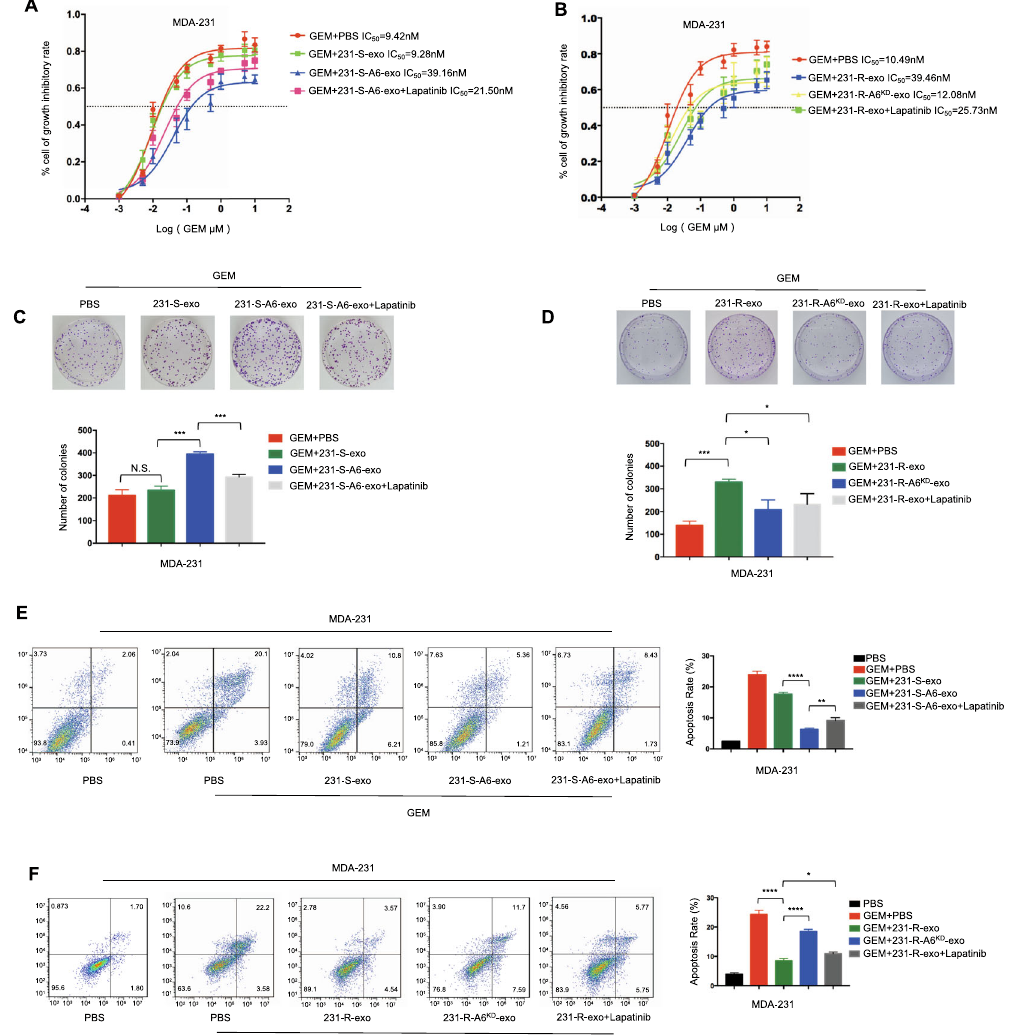
Fig. 6 EGFR-TKI reverses gemcitabine (GEM) resistance induced by exosomal ANXA6. A , B IC 50 values determined using the CCK-8 assay in MDA-231 cells treated with GEM + PBS, GEM + 231-S-exo, GEM + 231-S-A6-exo, and GEM + 231-S-A6-exo + lapatinib for 48 h or GEM + PBS, GEM + 231-R-exo, GEM + 231-R-A6 KD -exo, and GEM + 231-R-exo + lapatinib for 48 h. C , D Colony formation in MDA-231 cells treated with GEM + PBS, GEM + 231-S-exo, GEM + 231-S-A6-exo, or GEM + 231-S-A6-exo + lapatinib for 24 h and incubated for 7 days or GEM + PBS, GEM + 231-R-exo, GEM + 231-R-A6 KD -exo, or GEM + 231-R-exo + lapatinib for 24 h and incubated for 7 day. E , F Flow cytometric analyses of apoptosis in MDA-231 cells treated with PBS, GEM + PBS, GEM + 231-S-exo, GEM + 231-S-A6-exo, or GEM + 231-S-A6-exo + lapatinib for 24 h or PBS, GEM + PBS, GEM + 231-R-exo, GEM + 231-R-A6 KD -exo, or GEM + 231-R-exo + lapatinib for 24 h. All experiments were repeated three times, and the representative results are presented. Quantitative data are presented as the mean ± SD of triplicate experiments. * P < 0.05, ** P < 0.01, *** P < 0.001, and **** P <